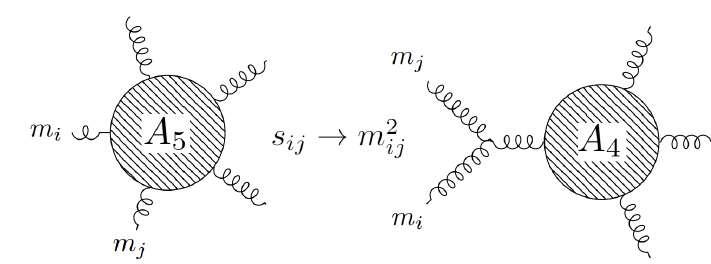
Figure 8 . Factorization limits of the 5-point amplitude. By only imposing the 4-point BCJ relations on A 4 for all possible factorizations, the 5-point BCJ can be satisfied